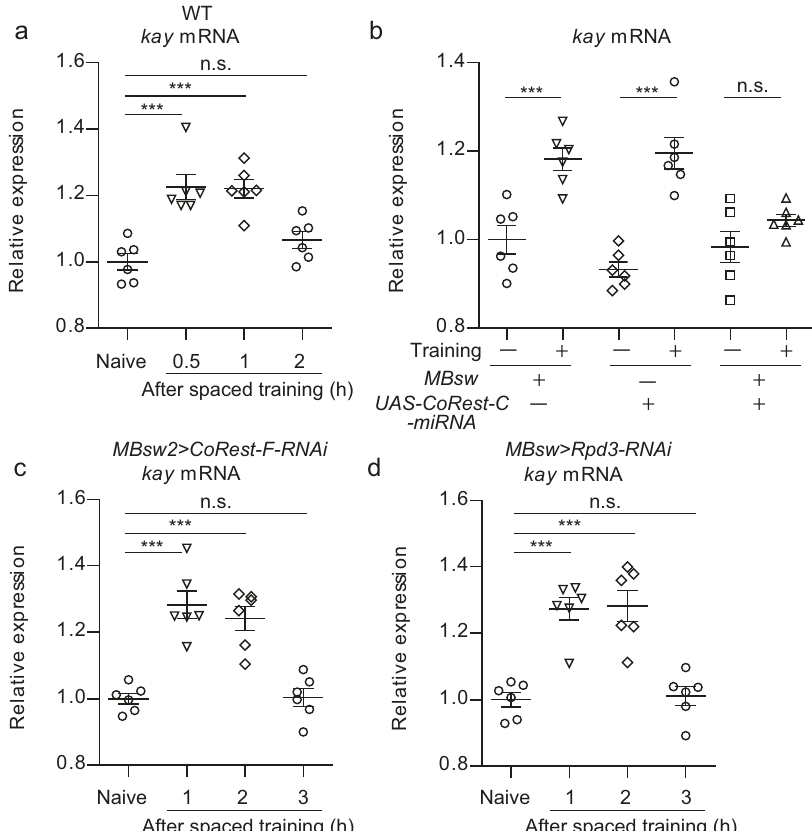
Fig. 3 The expression of kay mRNA is regulated by Rpd3/CoRest. a , b The expression of kay mRNA after spaced training requires CoRest-C. The fl ies carrying the indicated transgenes were fed normal food ( a ) or food containing RU ( b ), and subjected to spaced training. RNA extracted from the fl y heads at the indicated time ( a ) or 1 h ( b ) after spaced training were analyzed via RT-qPCR. c , d Dysfunction of Rpd3/CoRest-F delays the shutoff of kay mRNA expression. The fl ies were analyzed as in b . The genetic controls are shown in Supplementary Fig. 4. A one-way ANOVA ( P < 0.0001; n = 6 for all) followed by Tukey ’ s multiple comparisons (two sided) was performed. Data are represented as mean ± s.e.m. n.s., not signi fi cant, P > 0.05; *** P < 0.001, which is based on experimental replicates using different pooled samples, and the number is indicated as n above. Source data are provided as a Source Data fi